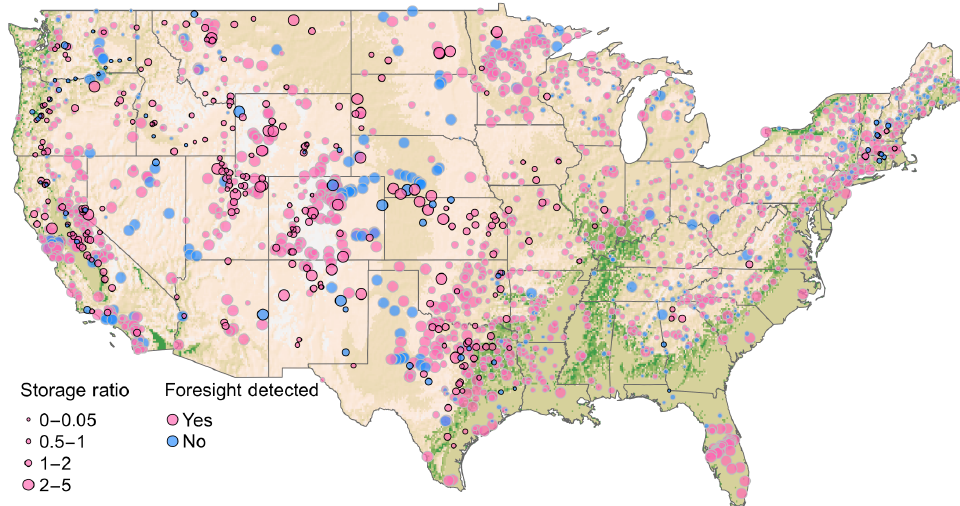
Figure 7. Foresight use for 1942 CONUS dams and reservoirs, based on horizon curves (316 dams; black outlined circles) and out-of- sample, extrapolated estimates (gray outlined circles). Storage ratio (split into four categories) is storage capacity divided by the annual average reservoir inflow. Background shading gives land